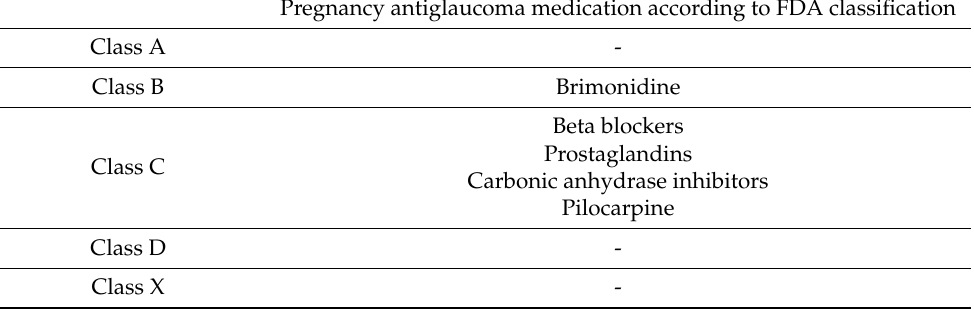
Table 3. Pregnancy antiglaucoma medication according to FDA classification